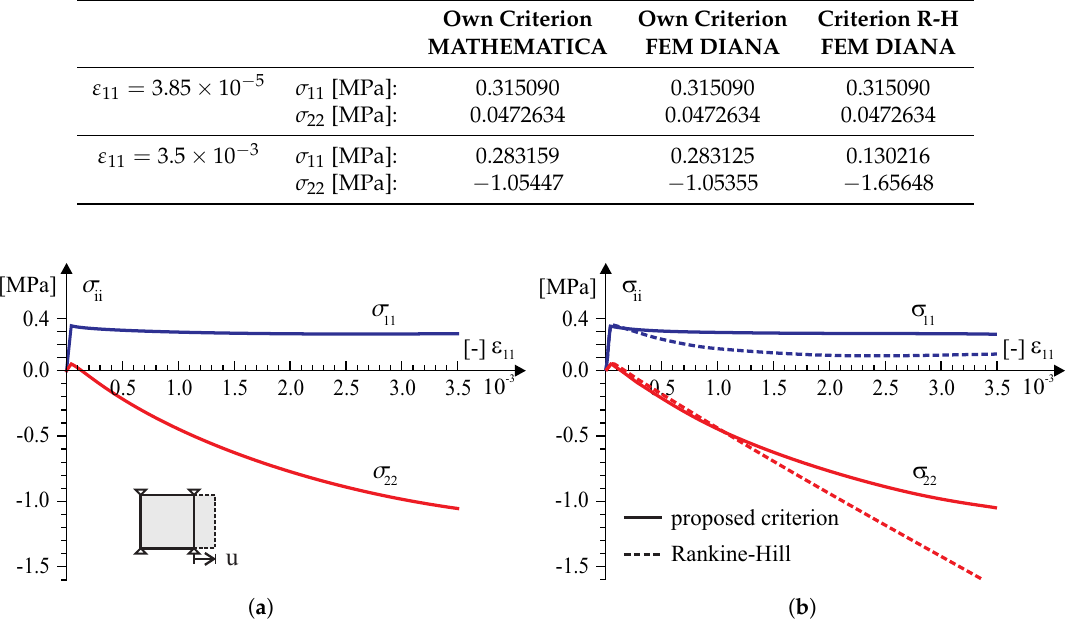
Figure 9. A homogeneous strain field ε 11 > 0 and ε 22 = 0 single element test results: ( a ) symbolic computation by MATHEMATICA [40], ( b ) finite element method (FEM) analysis in TNO DIANA [39].